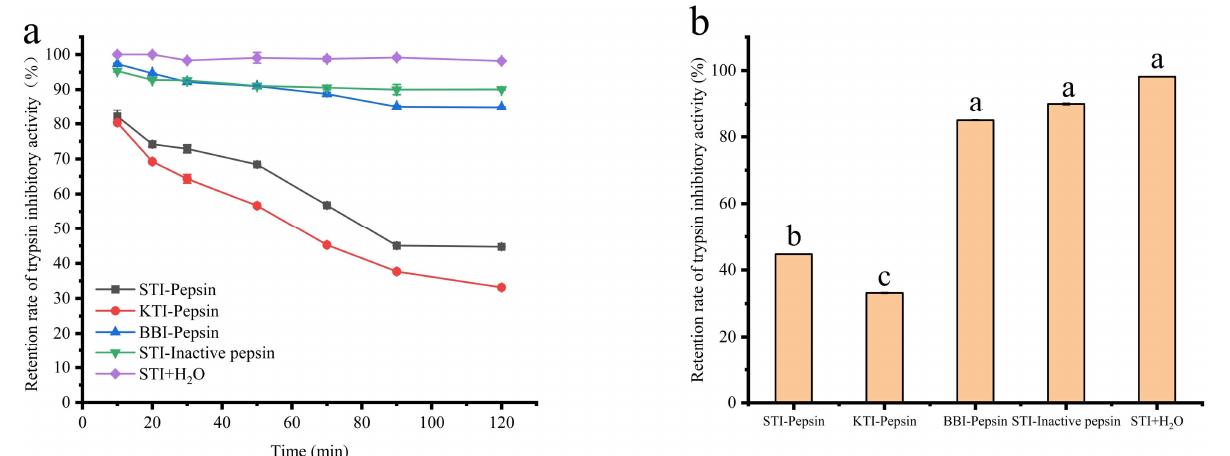
Figure 8. The effect of pepsin on the activity of soybean trypsin inhibitors ( a ). The retention rate of trypsin inhibitory activity after 120 min on the condition of pepsin treatment ( b ). Different letters indicate significant differences ( p < 0.05).